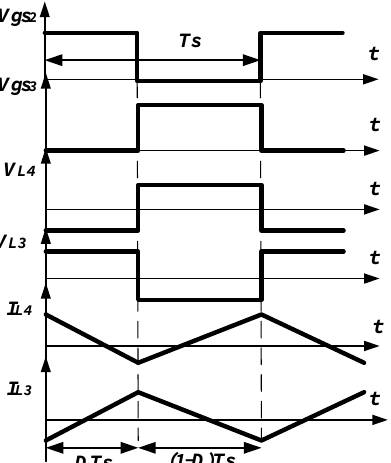
Figure 7. The state of the voltage and currents for the components of the QZSI block.